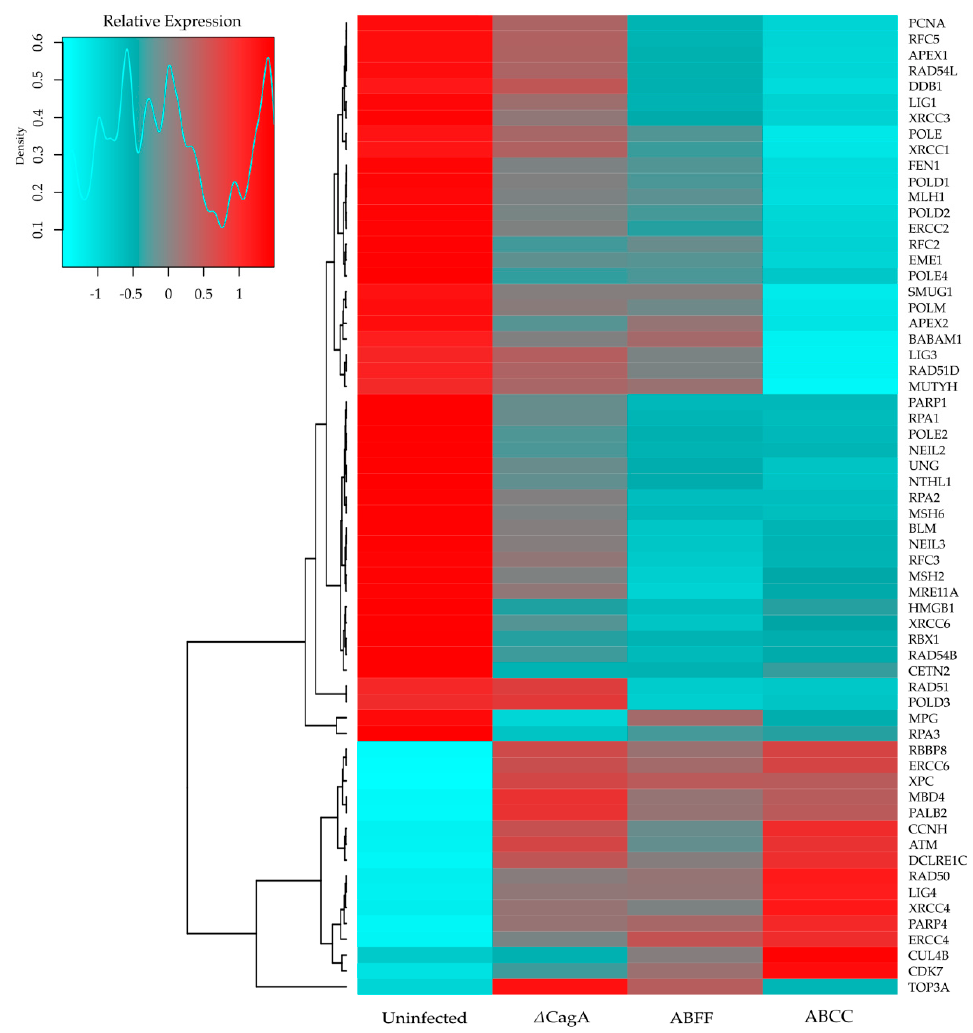
Figure 1. Gene expression profile related to DNA damage repair in the context of H. pylori infection. RNA-Seq analysis was performed on AGS cells infected with H. pylori P12 ABCC, ABFF, and Δ CagA strains.